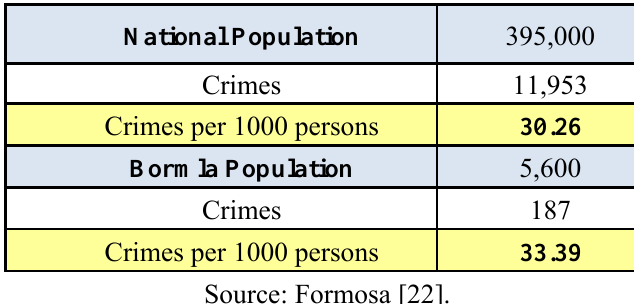
Table 2. Official crime rate in the Maltese Islands and Bormla in